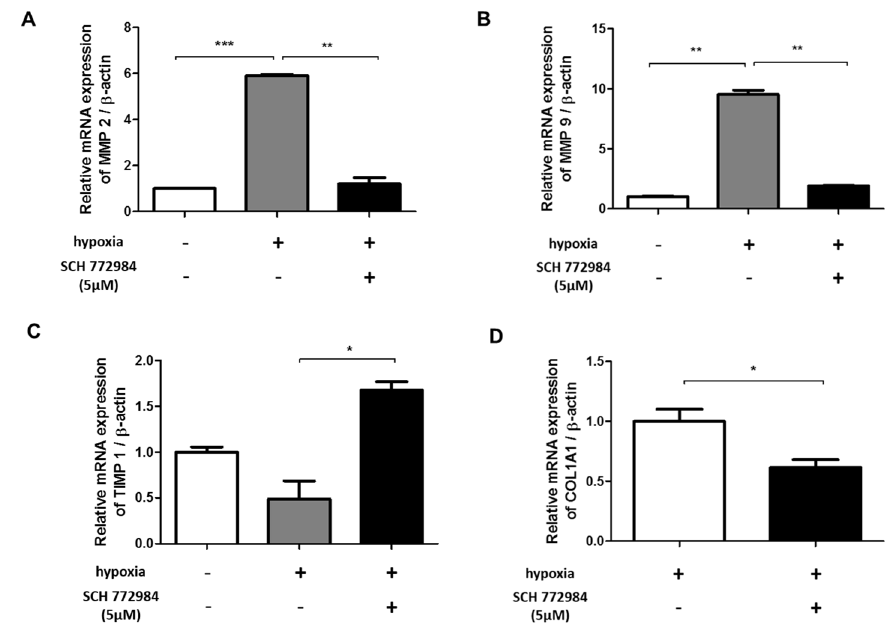
Figure 6. E ff ect of an ERK-specific inhibitor (SCH 772984) on MMP / TIMP and collagen levels